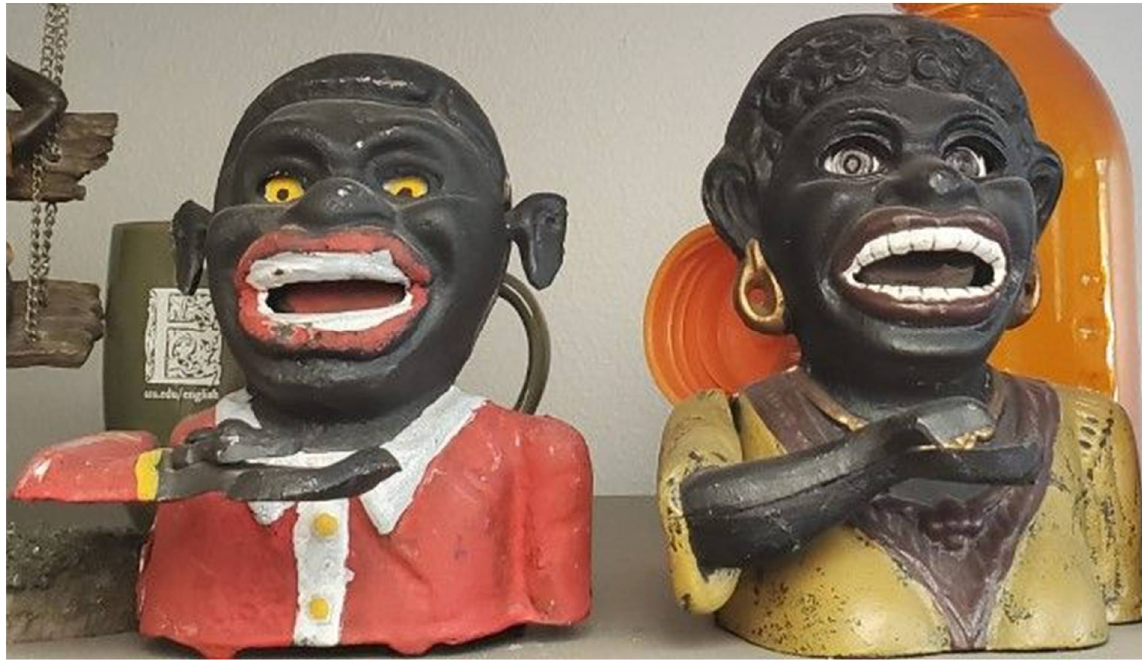
Figure 3. Uncle and Aunt Dinah cast iron “Jolly Nword Banks,” with an arm as lever, circa 1930s.